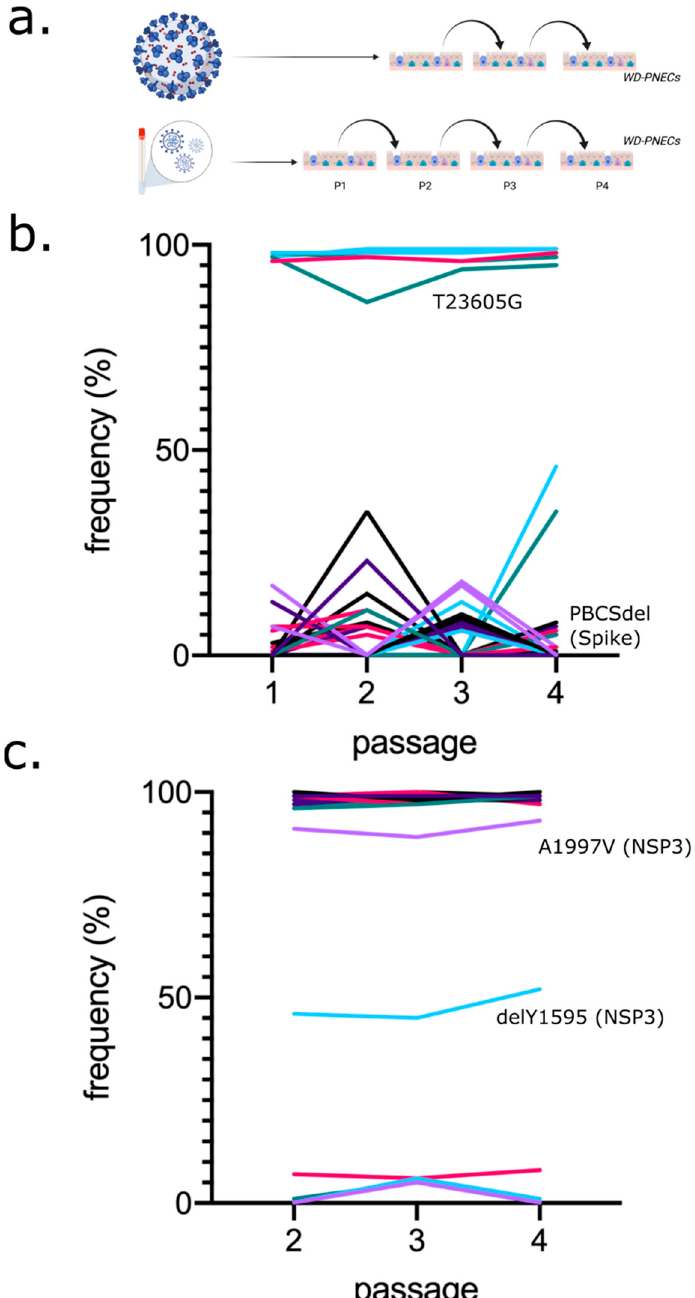
Figure 3. Analysis of PHE and BT20.1 whole-genome sequences during WD-PNECs passage. Schematic of SARS-CoV-2 isolation/passage series on WD-PNECs for PHE and BT20.1 ( a ). Frequency of mutations detected for PHE ( b ) and BT20.1 ( c ) passage series on WD-PNECs, respectively, relative to the reference sequence (Wuhan-Hu-1). Only sequences from P1-P4 (PHE) and P2-P4 (BT20.1) were analysed. PHE P1 is the original stock material obtained and hence is the same sequence as PHE P1 in Figure 2. Core changes were found consistently at a high frequency and minor variants were found at a consistently low frequency (e.g., <50%). Only variants that significantly changed in frequency are marked on the graph. Colours do not reflect relationships between variants. Figures were generated with the aid of BioRender.